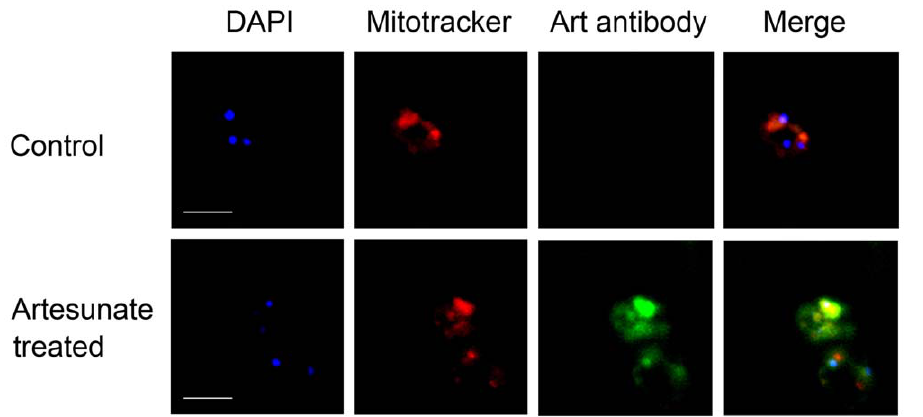
Figure 4. Artemisinins are distributed to the mitochondria. Immunofluorescence analysis revealed the subcellular localization of artesunate. Artesunate-treated P. berghei cells were stained with DAPI, Mitotracker Red and monoclonal antibody against artesuate. The top and bottom panels are cells without or with artesuate treatment, respectively. Some of the artesuate immunofluorescence signal is colocalized with mitochondria. Scale bar, 5 m